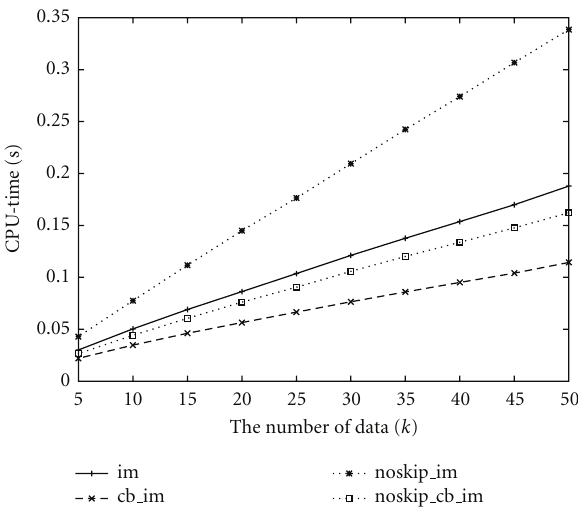
Figure 10: CPU time on 5-dimensional data (enlarged